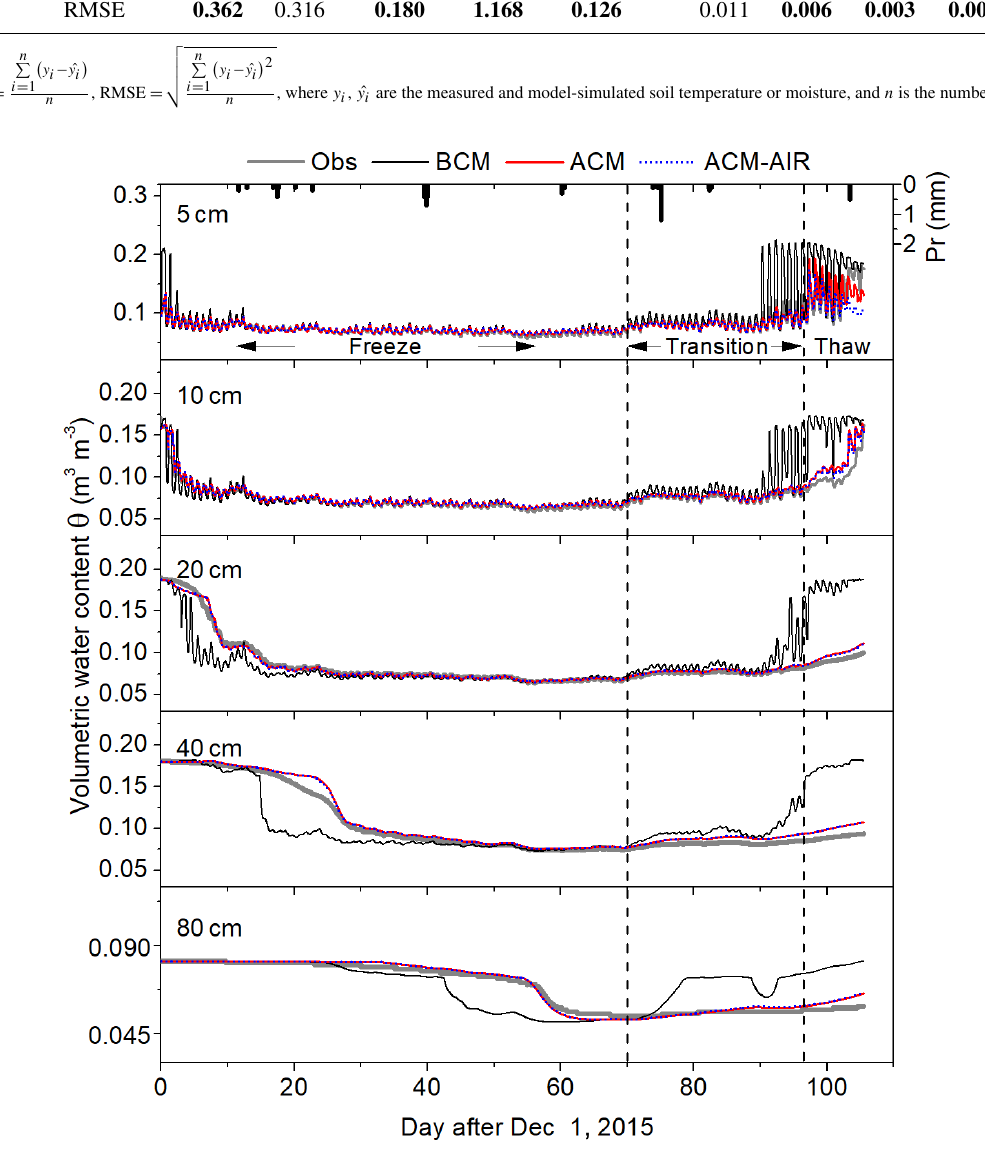
Figure 3. Comparison of measured (Obs) and model-simulated time series of soil moisture at various soil layers using the basic coupled model (BCM), advanced coupled model (ACM), and advanced coupled model with airflow